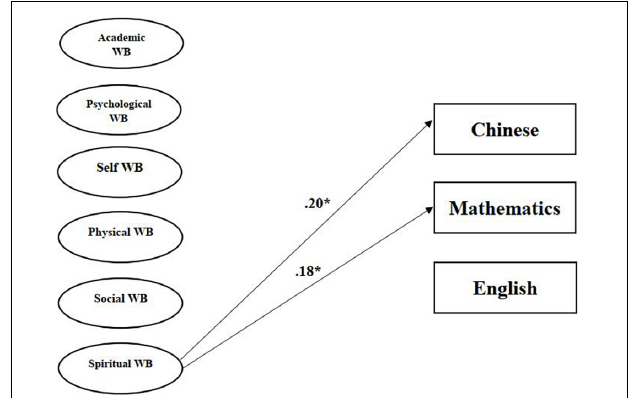
FIGURE 1 | The model of Multiple Well-being (WB) and student achievement. Intercorrelations and error terms were removed for simplicity. *Regression path is significant at the 0.05 level